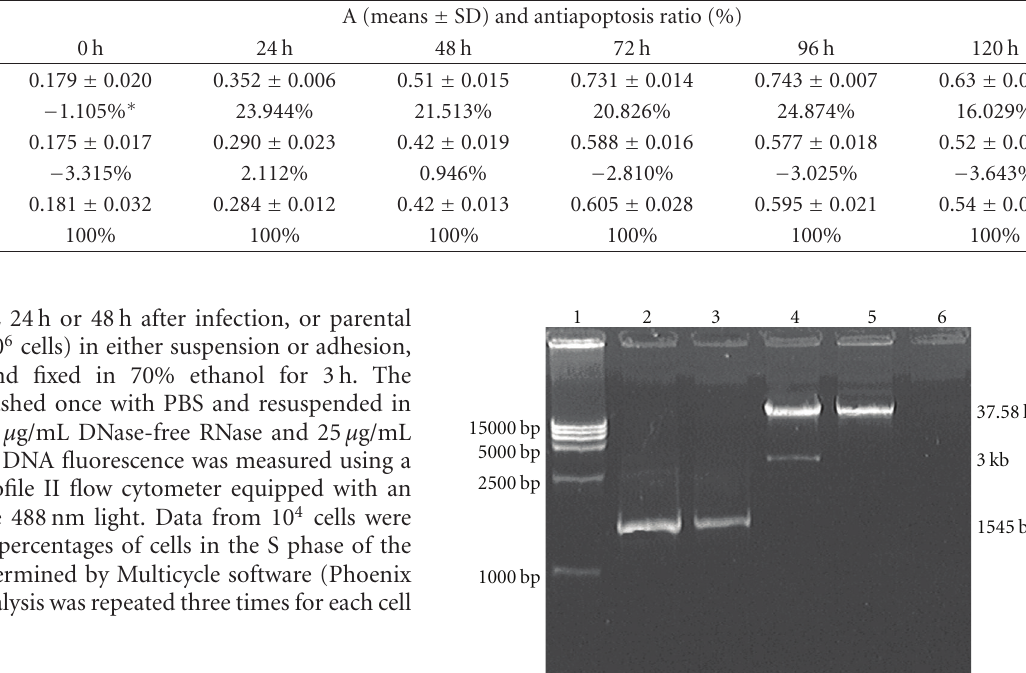
Table 1: Antiapoptosis activity of LMP2A on SGC cells.